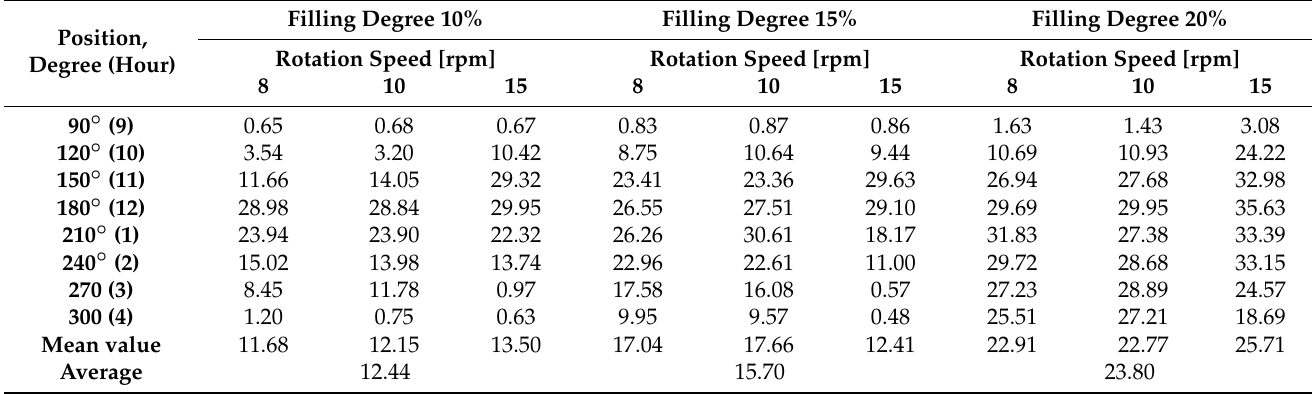
Table 2. The percentage of area occupied by the particles ( AOR %) for hook-type flights.